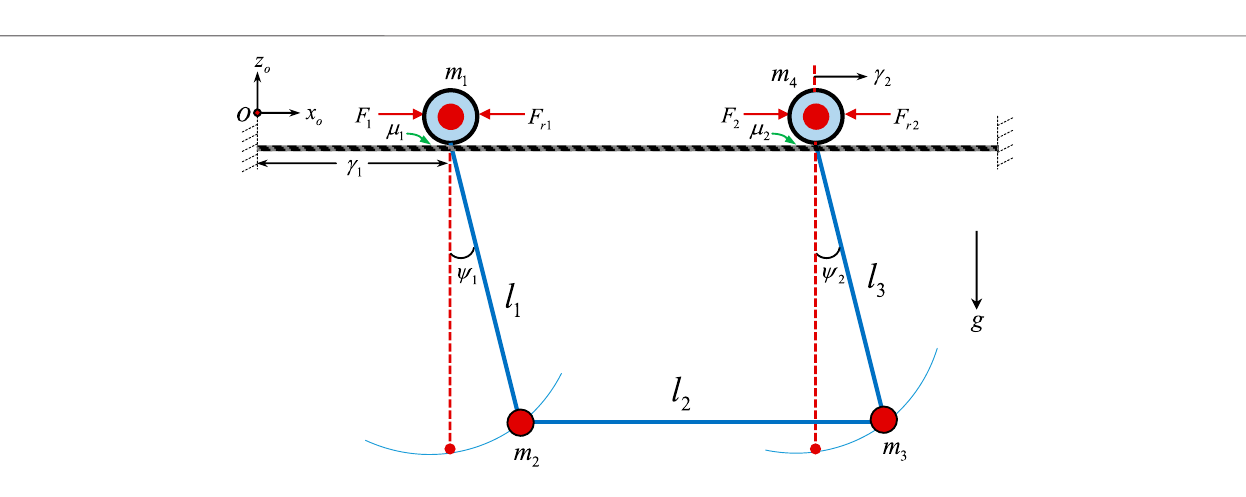
Frontiers in Robotics and AI |